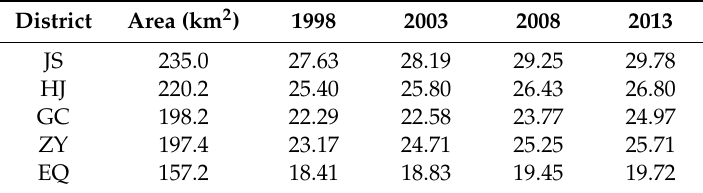
Figure 11. Runoff from SCS model in different regions in different periods (10 6 m 3 ).